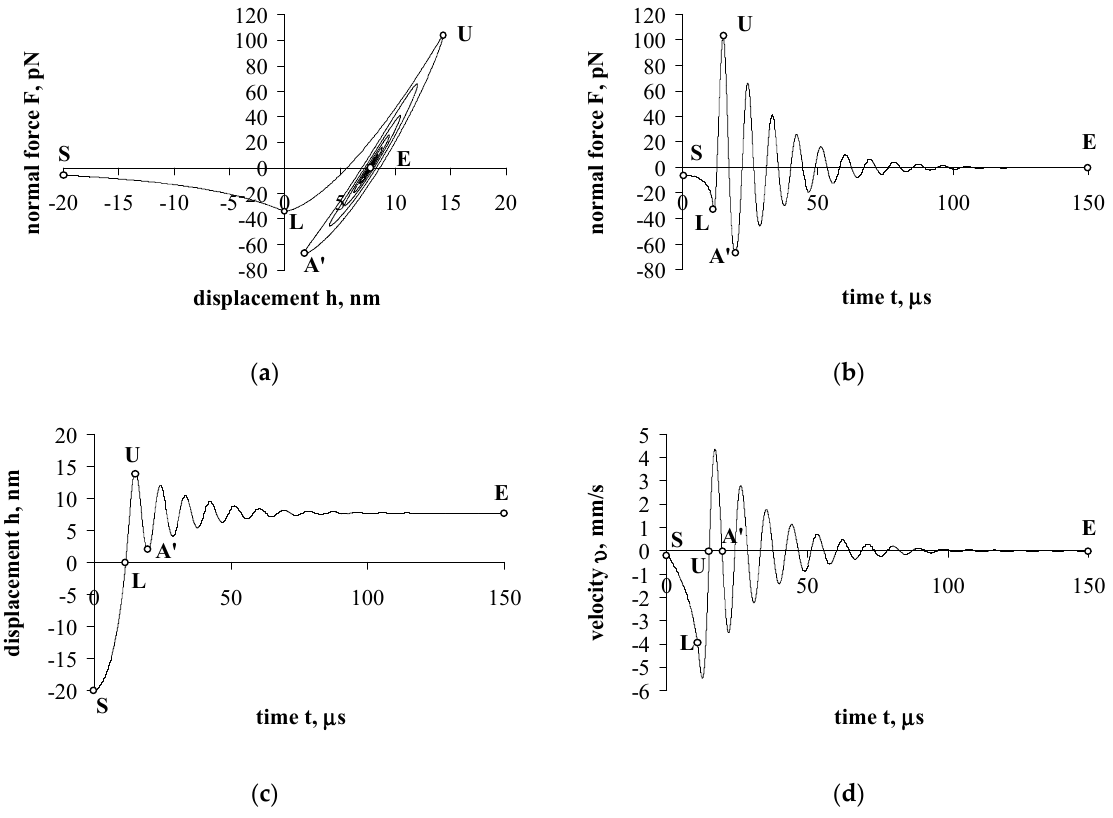
Figure 2. Interaction of an erythrocyte with a blood clot (fibrin and platelets). Without drag force. Dependence of the normal force on displacement ( a ) and time ( b ); dependence of displacement ( c ) and velocity ( d ) on time.